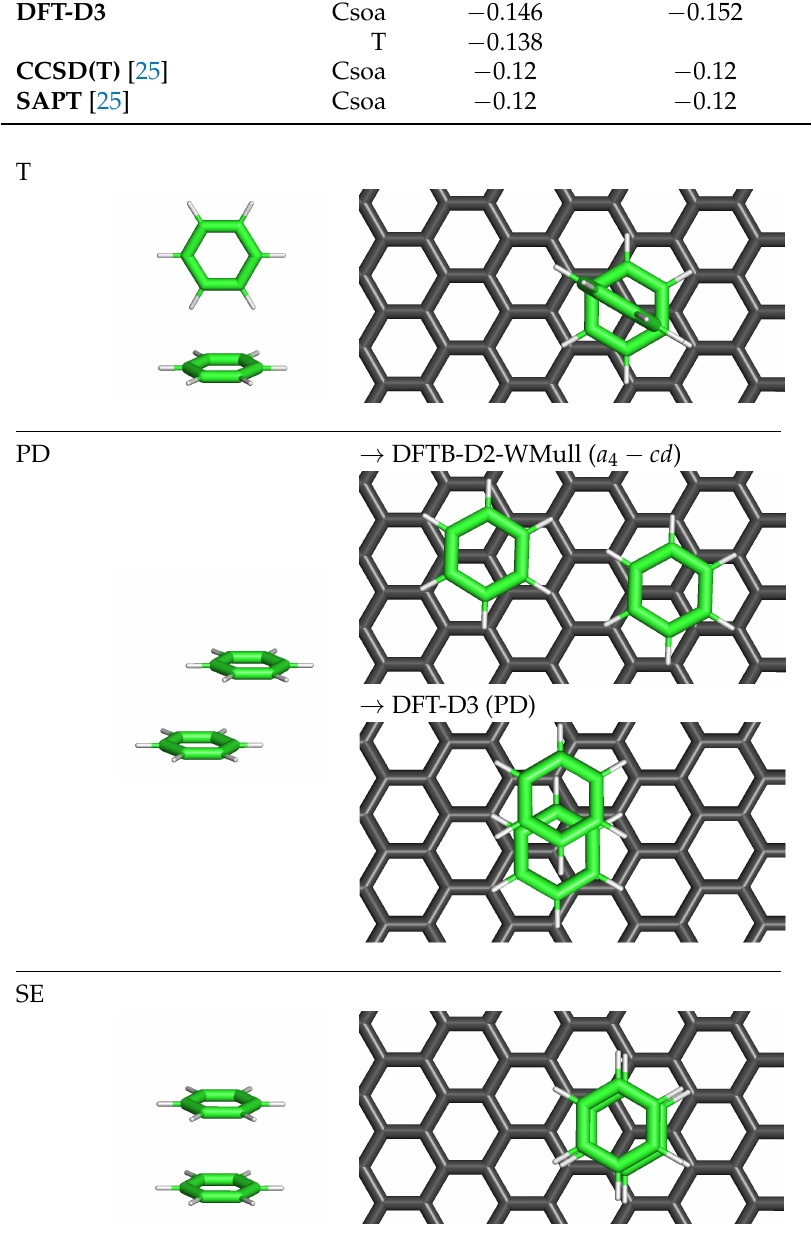
Figure 2. Benzene dimers bz 2 in vacuum and deposited on